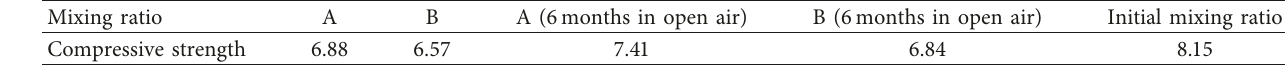
Table 3: Average compressive strength of blocks